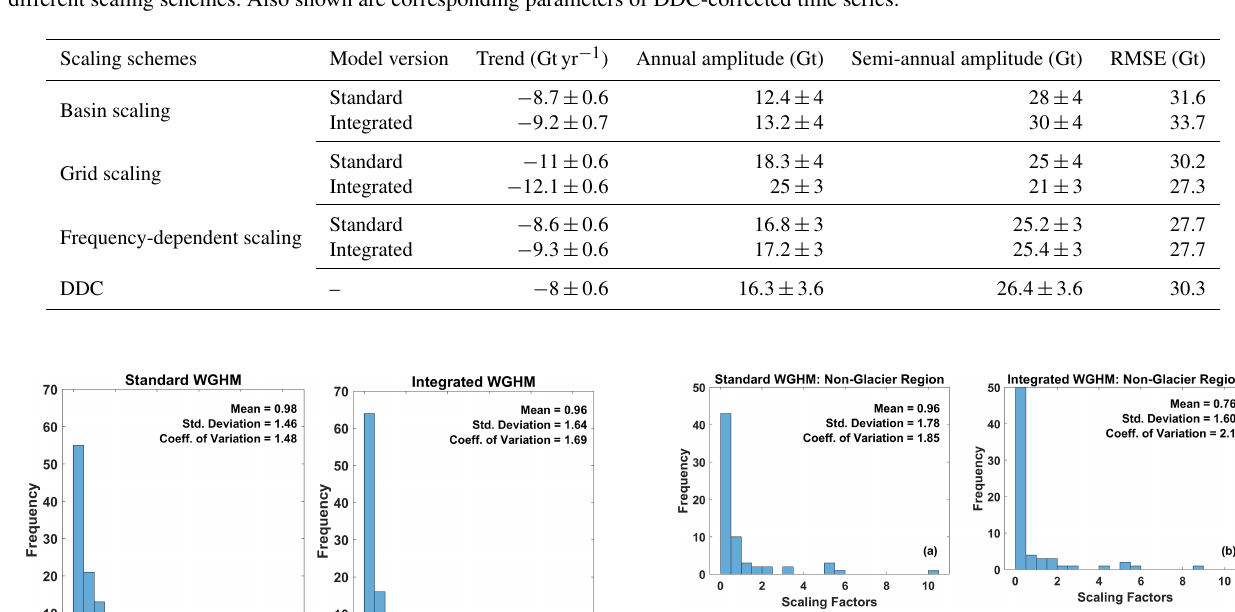
Figure 10. Gridded scaling factor map from the standard (a) and integrated (b) version of WGHM. The grid size is 1 ◦ equiangular. Table 5. Parameters along with their formal uncertainties from time series fit to basin averages from scaled GRACE SH estimates under different scaling schemes. Also shown are corresponding parameters of DDC-corrected time series.